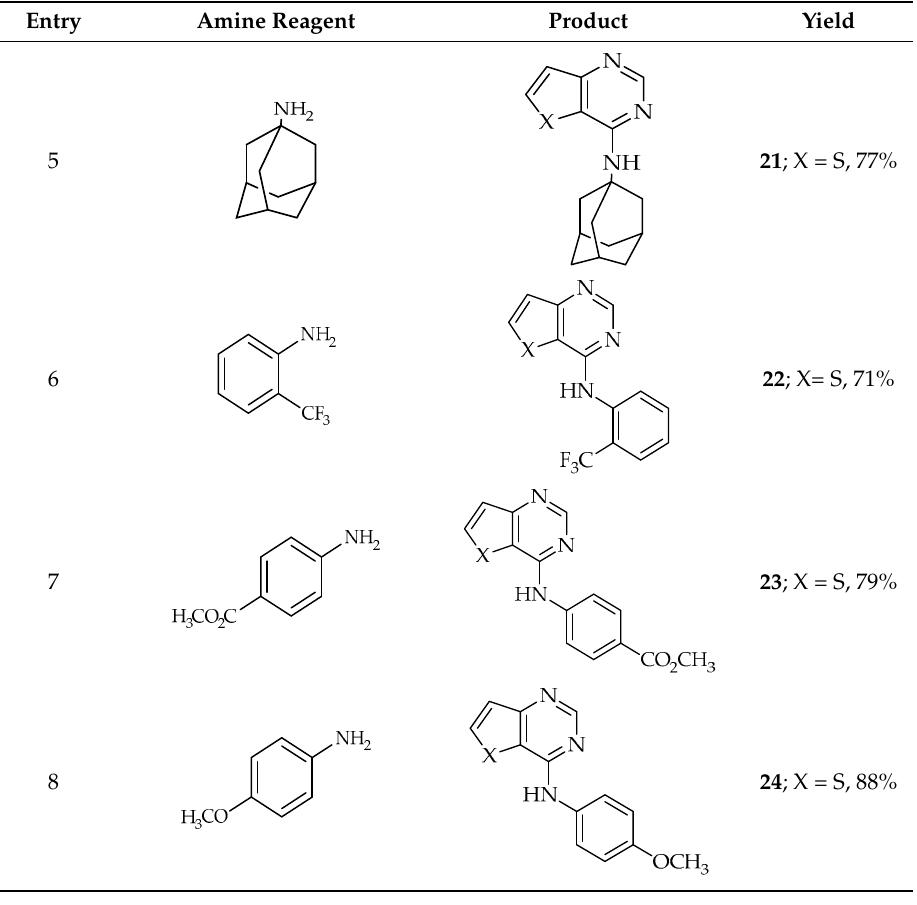
Table 2. Results of S N Ar on 7-chloro-5-methyl-[1,2,4]triazolo[1,5- a ]pyrimidine with various amines. Amine Reagent